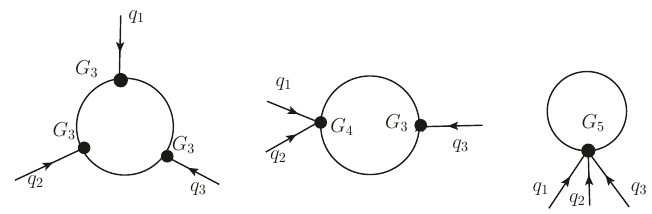
Figure 5. Diagrams that contribute to the one-loop correction (3.35) to the e(cid:11)ective action. It follows that for the SO( N ) F